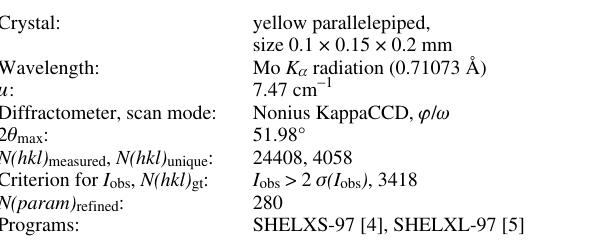
Table 1. Data collection and handling.